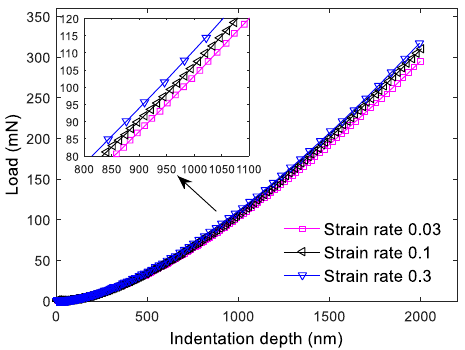
Figure 2. Load–depth curves under three different strain rates of 0.03, 0.1, and 0.3 s −1 .